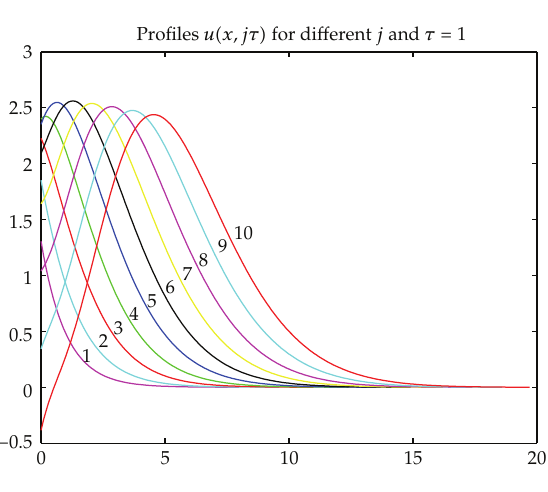
Figure 8: Example 5.1 by infinite system.